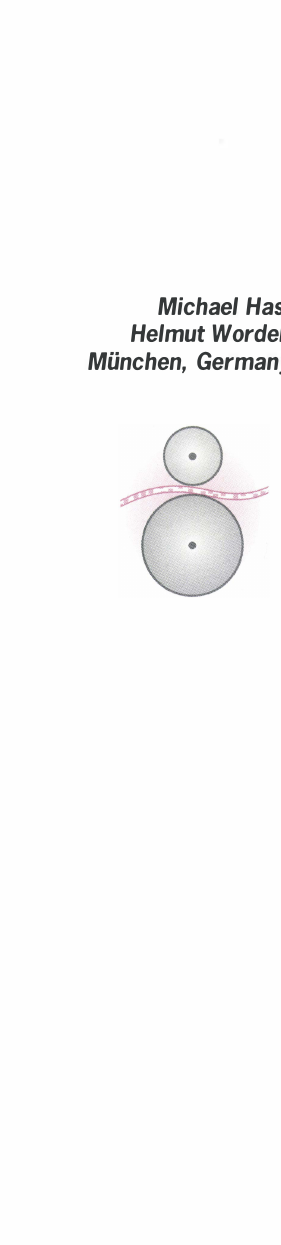
Figure 1: Conventional arrangement